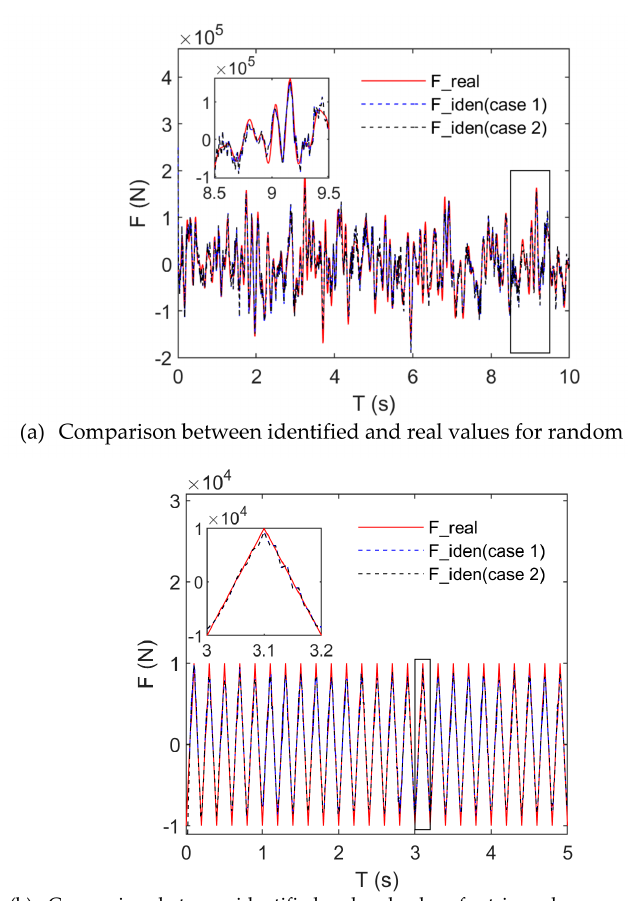
Figure 12. Comparison between identified and real values (noise level: 5%). Table 3. Correlation coefficients of load identification and real values (noise level: 5%).